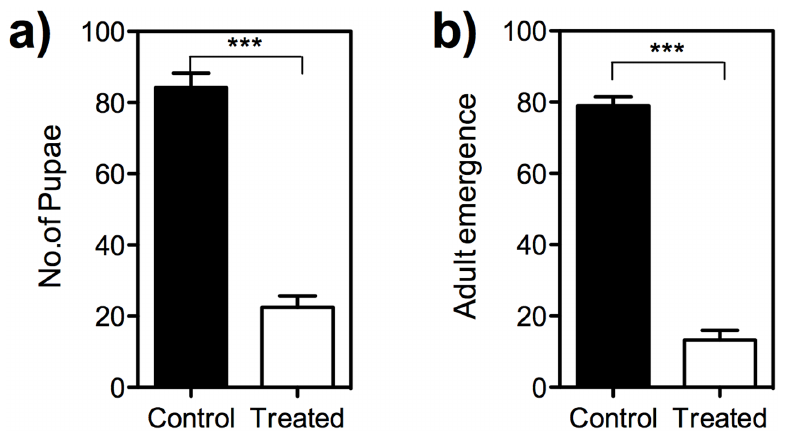
Fig 6. The assay of B . dorsalis development in the control and SA treated fruit. (a) The number of pupae formed; (b) The number of adults emerged. The pupal and adult emergence decreased in the SA treated fruit when compared to the control (unpaired t test, t = 11.93, df = 6, P = 0.0001 [pupae], t = 17.96, df = 6, P = 0.0001 [adults emerged]). Error bars = Standard error of mean.